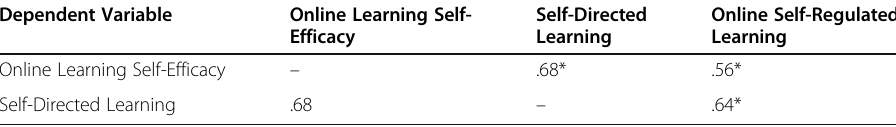
Dependent Variable Online Learning Self-